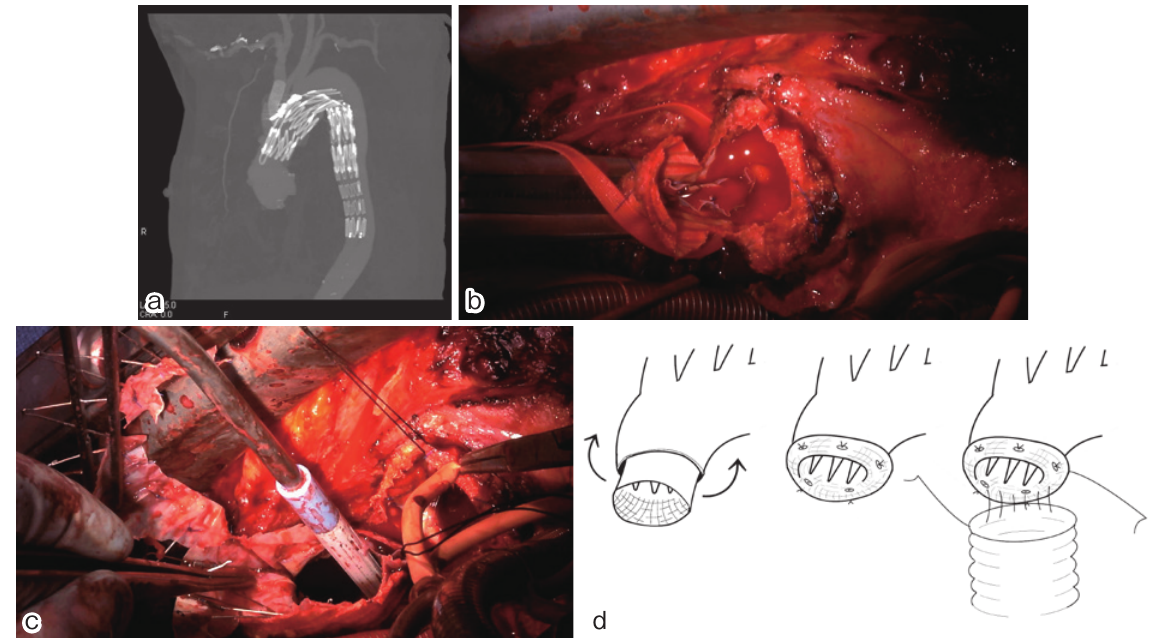
Figure 1. Pre-operative and intra-operative findings. ( a ) Computed tomography image showing the proximal site of the endograft adjacent to the proximal anastomosis site of the ascending aortic graft. ( b ) The proximal site of the endograft is detected outside the clamp site of the ascending aortic graft. ( c ) Resection of the proximal portion of the stent graft. ( d ) Turn-over fixation of the residual edge of the stent